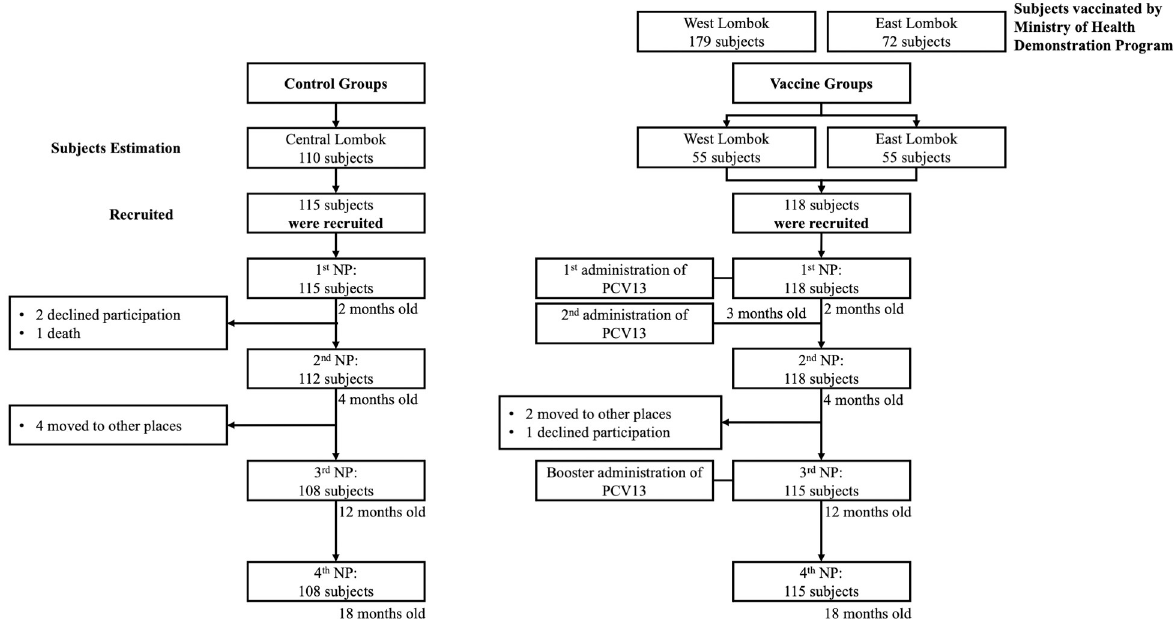
Fig 1. Flow chart of participants in the study.